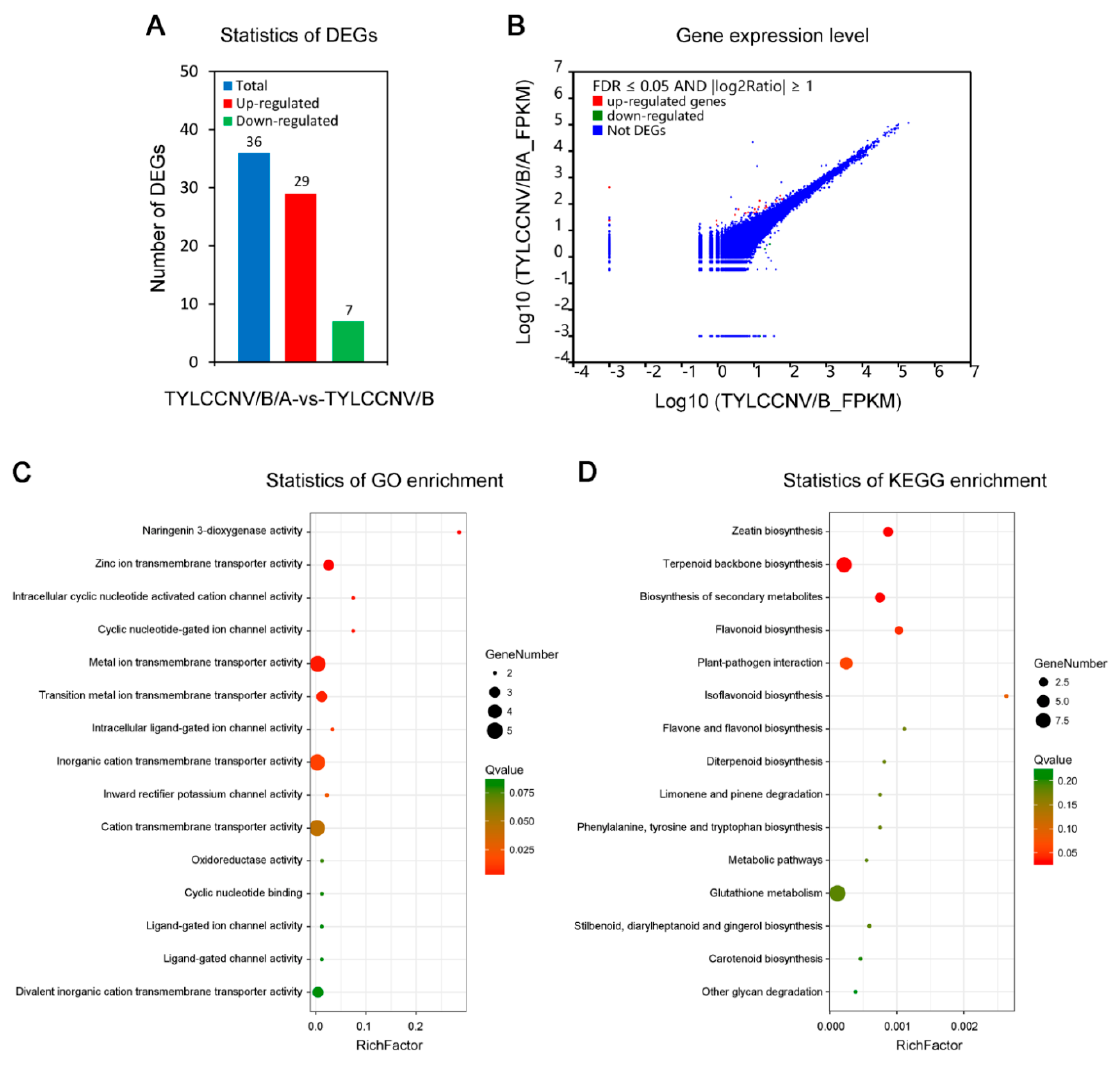
Figure 5. Transcriptome analysis of N. benthamiana seedlings in response to TYLCCNA (TYLCCNV/B/A-vs-TYLCCNV/B). ( A ) The numbers of total, up-regulated and down-regulated differentially expressed genes (DEGs) in leaves of N. benthamiana seedlings upon TYLCCNV (TYLCCNV/B/A-vs-TYLCCNV/B). ( B ) Volcano plot analysis of DEGs in leaves of N. benthamiana seedlings upon TYLCCNV (TYLCCNV/B/A-vs-TYLCCNV/B). ( C ) The GO term enrichment analysis of DEGs in leaves of N. benthamiana seedlings upon TYLCCNV (TYLCCNV/B/A-vs-TYLCCNV/B). The top 15 enriched GO terms are shown. ( D ) The KEGG term enrichment analysis of DEGs in leaves of N. benthamiana seedlings upon TYLCCNV (TYLCCNV/B/A-vs-TYLCCNV/B). The top 15 enriched KEGG terms are shown.